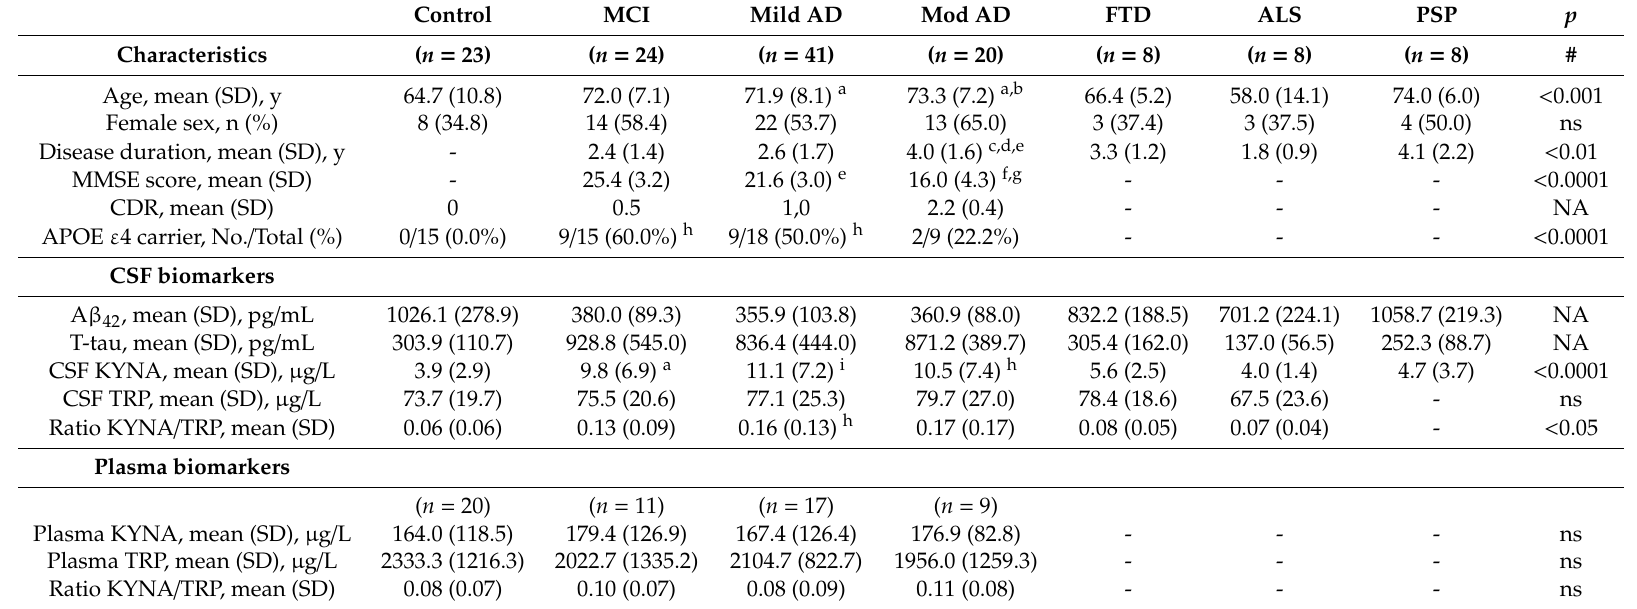
Table 1. Demographic and biomarker characteristics of the study